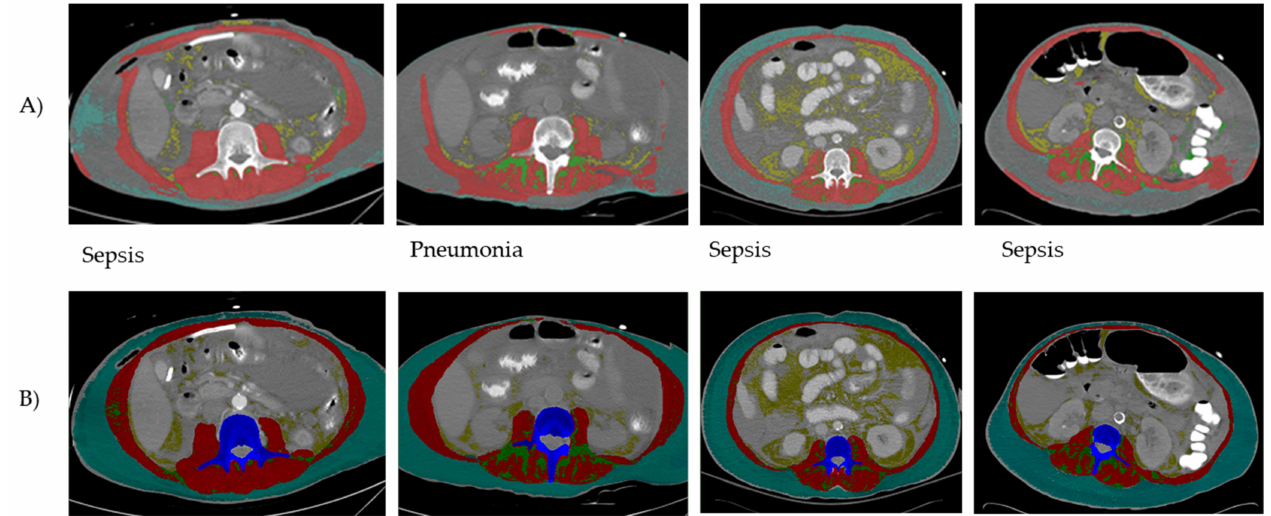
Figure 1. Examples of CT images following AutoMATiCA (test method) analysis ( A ) compared to semi-automated SliceOmatic (reference method) analysis ( B ). Discrepancies in tagging (i.e., coloring of different tissues) by the test method were noticed for all the abdominal tissues at this landmark (skeletal muscle and adipose tissues). The inconsistent performance of the test method was noted mainly in patients with a critical illness